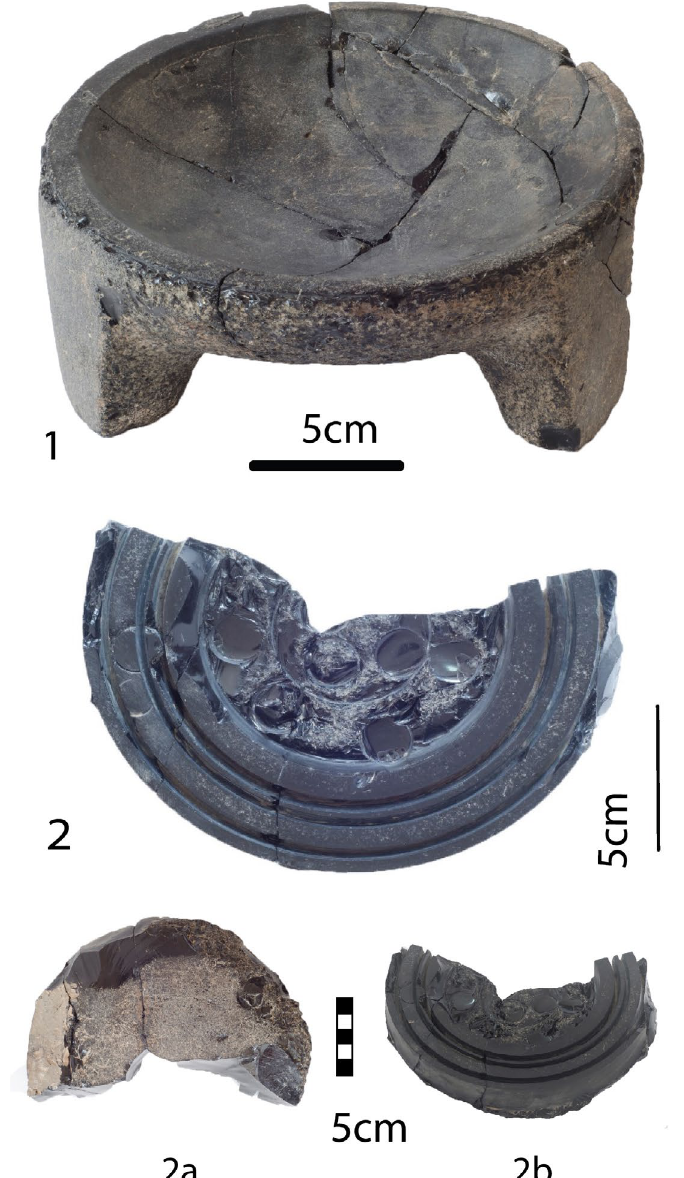
Figure 9. Two of the unfinished vessels from the vase maker’s workshop at Alalakh. No. 1 a tripod mortar (AT 48/100); both the interior and exterior surfaces have been hammer dressed and ground smooth ready to be finished by polishing and buffing. No. 2 a bowl in the process of being hollowed out (AT/48/99). No. 2a shows the bottom and outside surface; note the rough shaping and presence of cortex. No. 2b an interior view showing series of concentric cuts made by large tubular drills of different diameter; the inner part of the bowl has been hollowed out, the drill stumps show scars indicating that they were broken off by flaking perhaps using a chisel, or similar. Photographs courtesy of Murat Akar (Tell Atchana